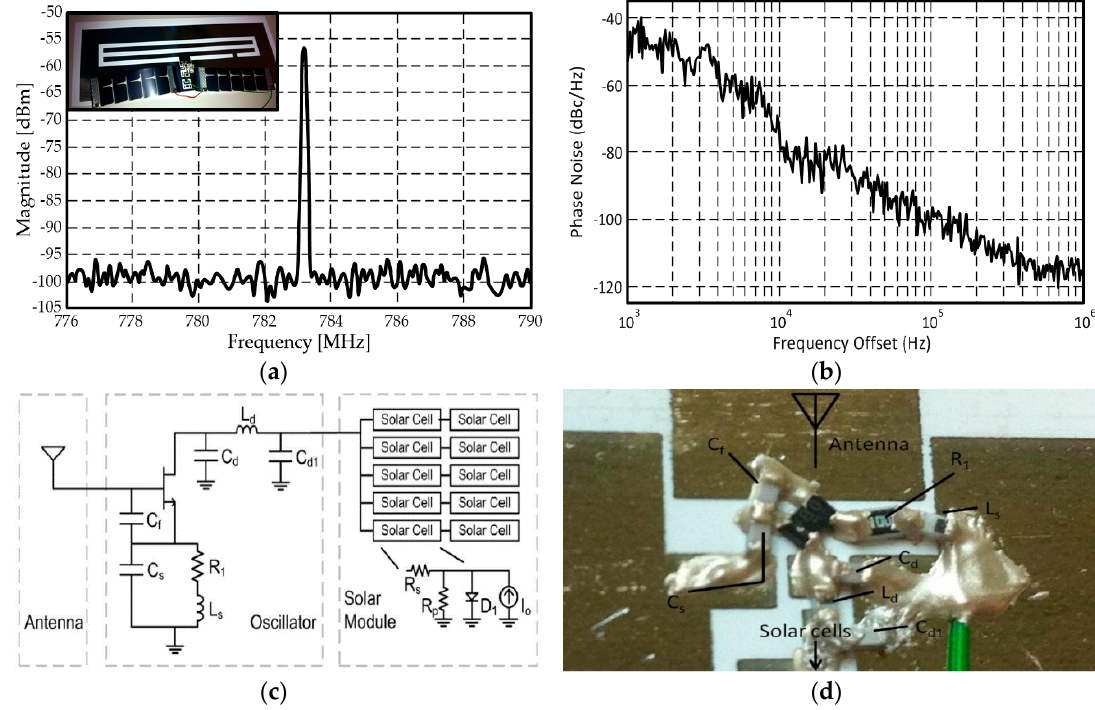
Figure 15. Active antenna on paper: Measured ( a ) spectrum; ( b ) phase noise; ( c ) system schematics; and ( c ) fabricated oscillator.